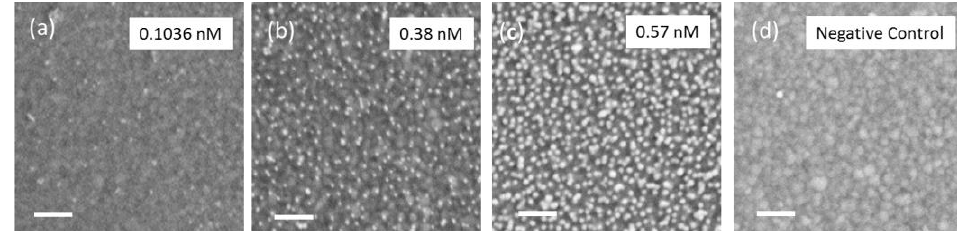
Figure 7. ( a – c ): SEM images of MPA–AuNP deposited from solutions with concentrations of 0.1036 nM, 0.38 nM and 0.57 nM, respectively, showing an increased density of the adsorbed MPA–AuNP. ( d ) A SEM image of the negative control of a SAW chip treated with 0.1036 nM MPA–AuNP but without initial AUT surface functionalization. Scale bar is 100 nm.